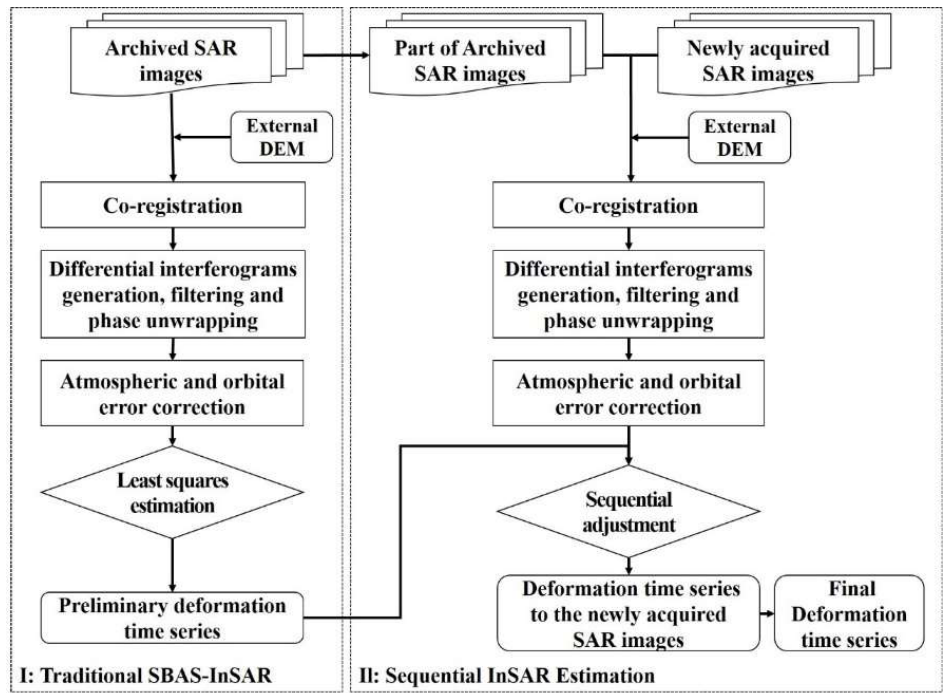
Figure 3. Flowchart of progressive SBAS-InSAR processing.